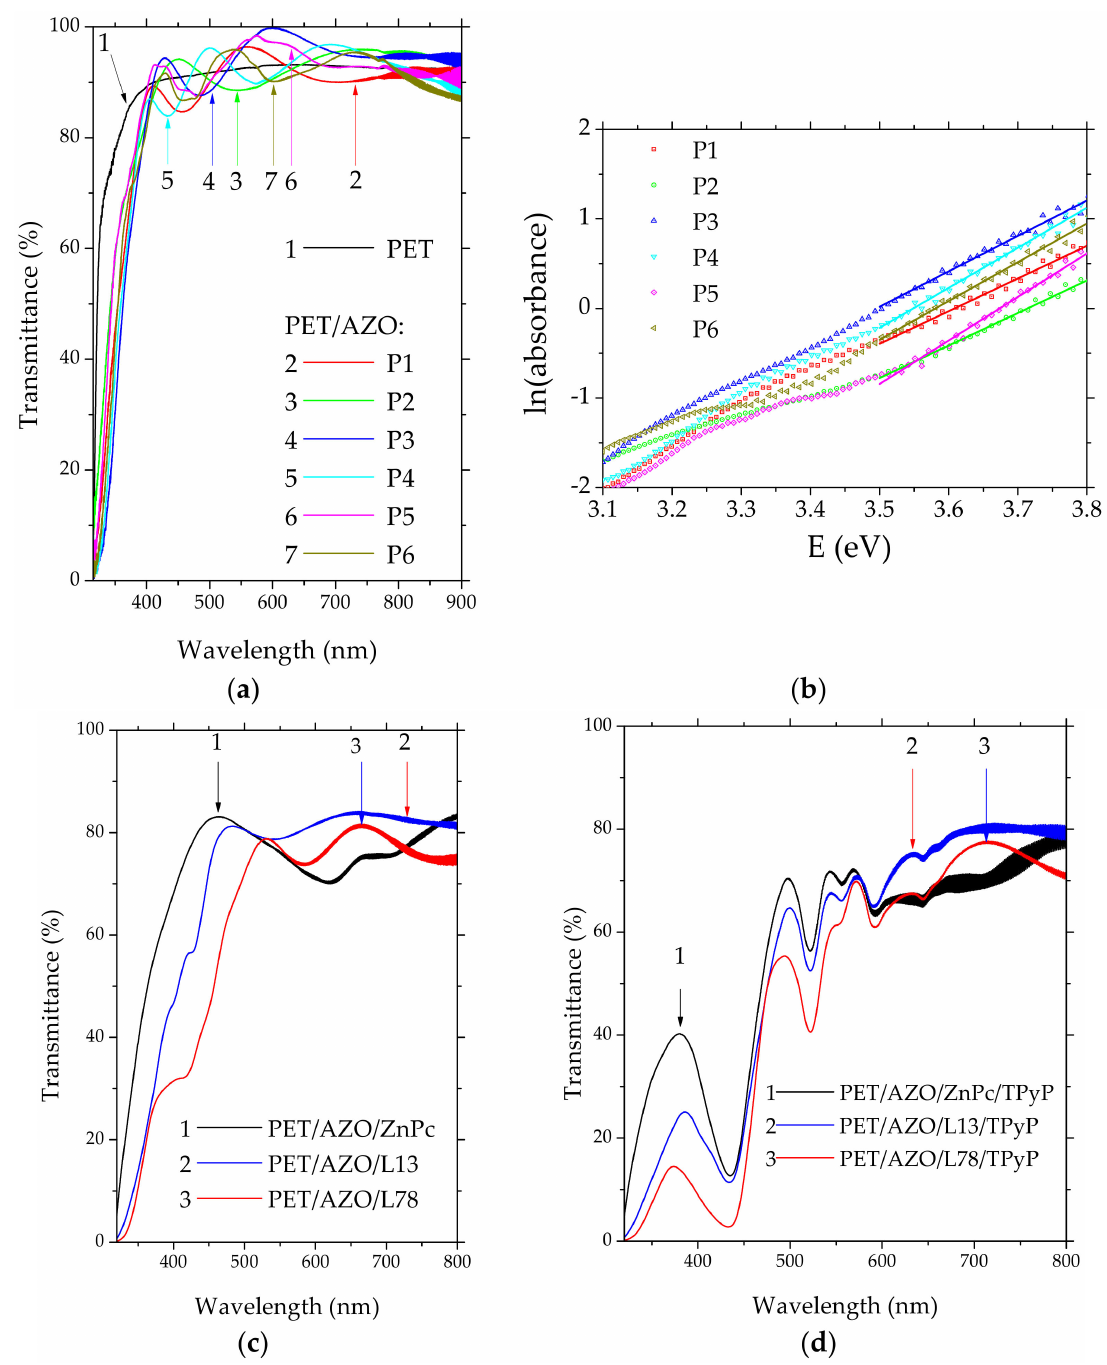
Figure 4. UV-Vis transmission spectra of AZO layer deposited on PET ( a ); single-layer organic heterostructures on PET/AZO ( c ); bi-layer organic heterostructures on PET/AZO ( d ). Urbach law for AZO layer deposited on PET ( b ). The substrates for ( c , d ) are indicated in Table